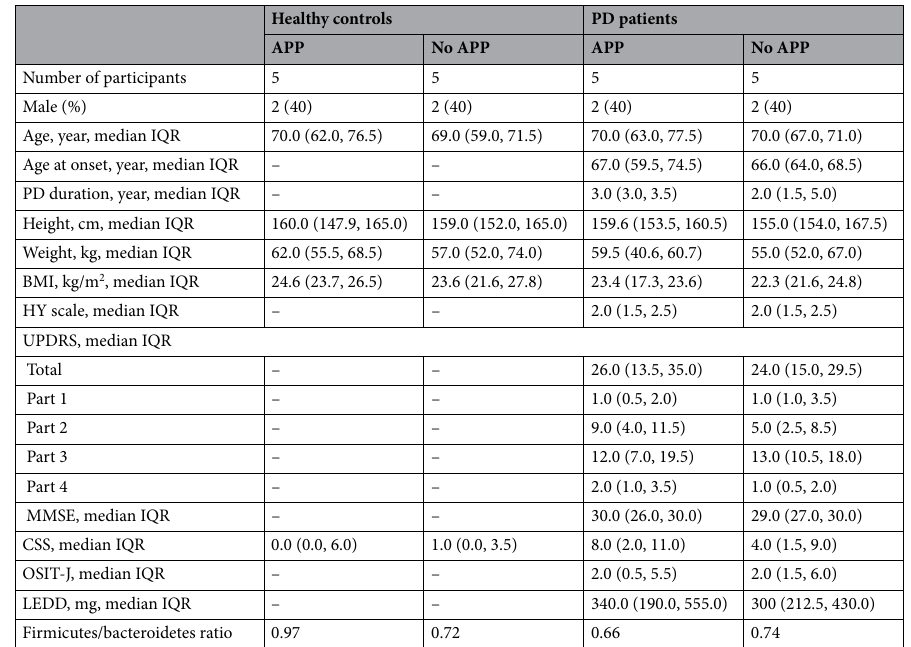
Table 1. Demographic and clinical features. APP appendectomy, PD Parkinson’s disease, IQR interquartile range, LEDD levodopa-equivalent daily dose, OSIT-J Odor Stick Identification Test for Japanese,